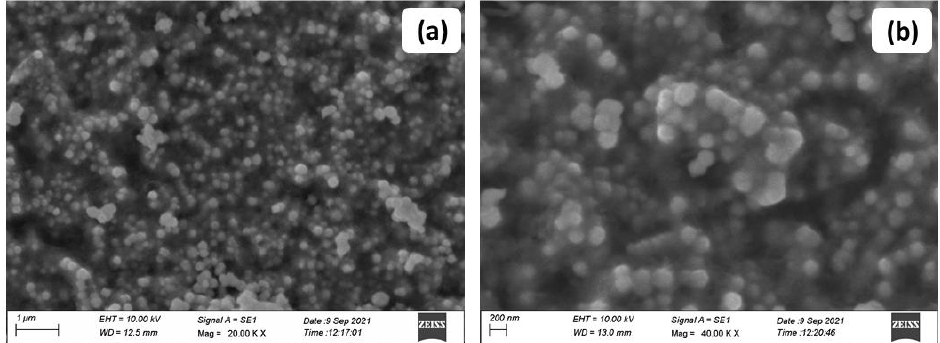
Figure 4. ( a , b ) Scanning electron microscopy of the MAL-CNPs at different magnifications.